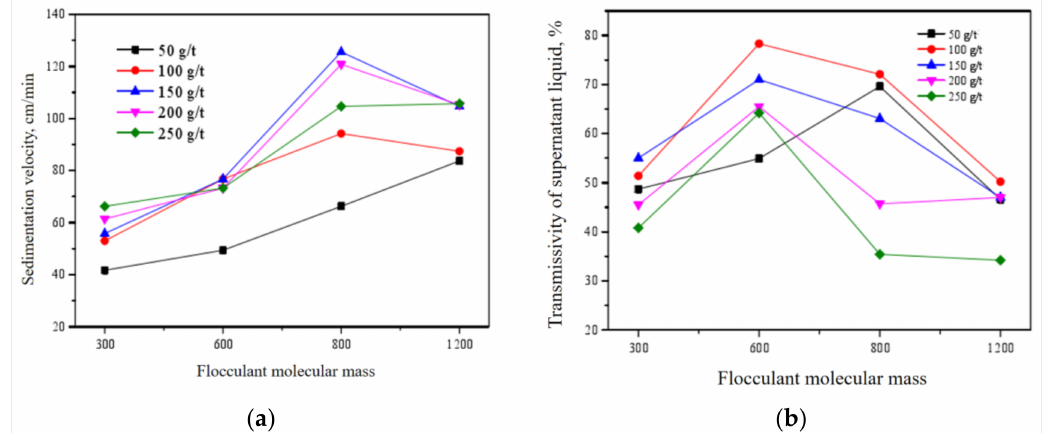
Figure 11. Testing results of different flocculant molecular mass. ( a ) Sedimentation velocity; ( b ) transmissivity of super- natant